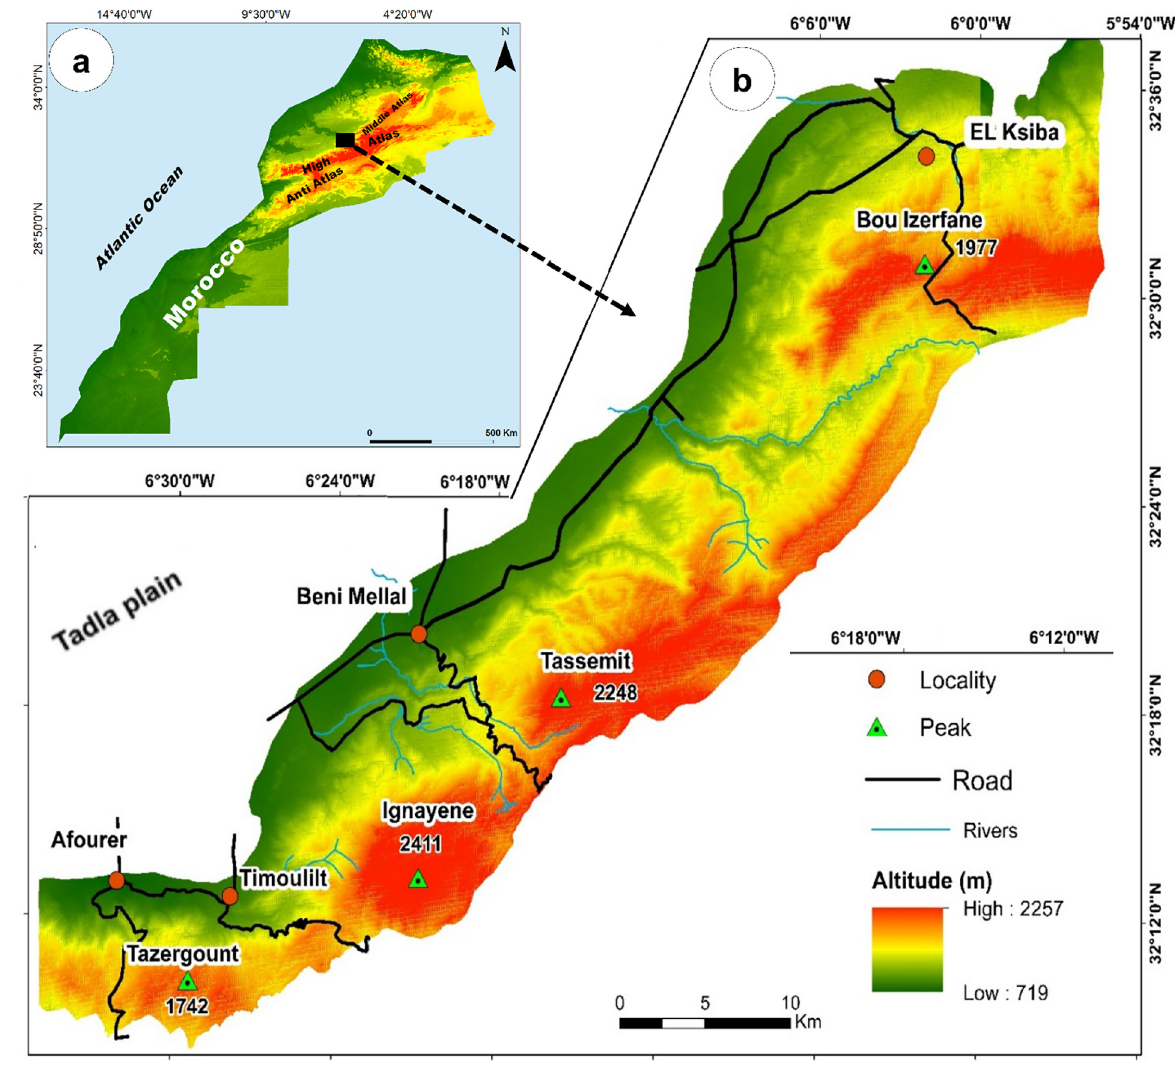
Fig. 1. location of the study